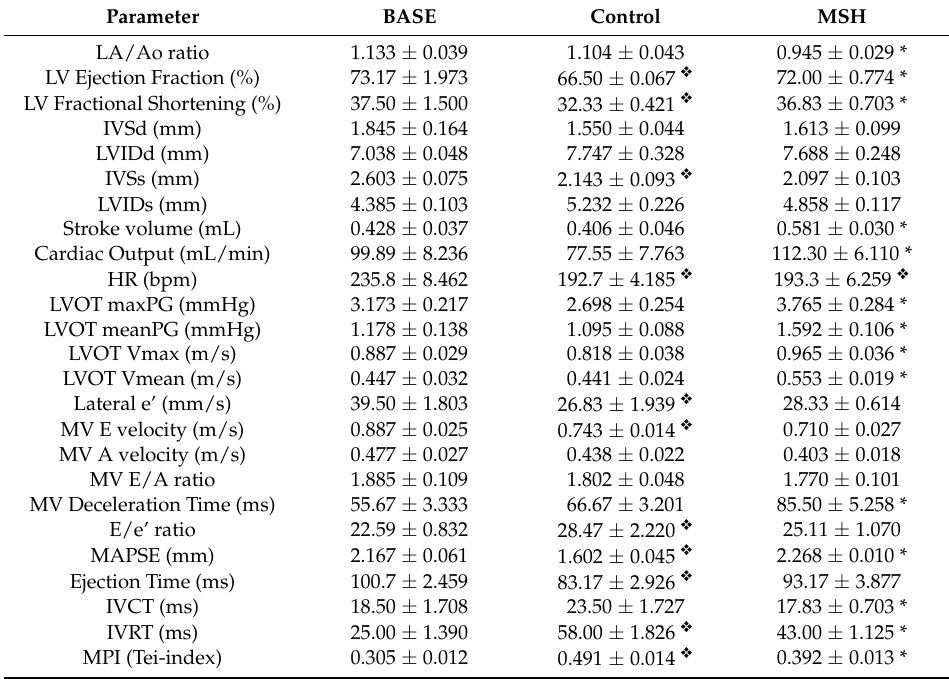
Table 2. Echocardiographic parameters of untreated control and alpha-MSH-treated ZDF rats at the baseline and at the endpoint of the study. Ejection fraction (EF), fractional shortening (FS), stroke volume (SV), cardiac output (CO) and mitral plane systolic excursion (MAPSE) were elevated in treated group. Isovolumic relaxation time (IVRT) and isovolumic contraction time (IVCT) were lengthened in ZDF animals, but shortened in alpha-MSH-treated group. Myocardial Performance Index (MPI or Tei-index) and left atrium to aortic ratio (LA/Ao) were also improved after the treatment. One-way ANOVA was used to estimate statistical differences. (cid:118) vs. BASE, p < 0.05; * vs. Control, p <